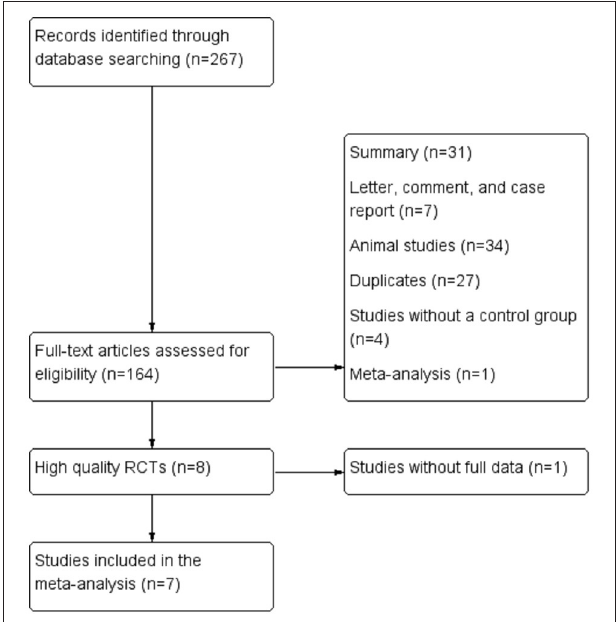
FIGURE 1 | Flow chart of the selection of studies for inclusion in the meta-analysis. RCT, randomized controlled